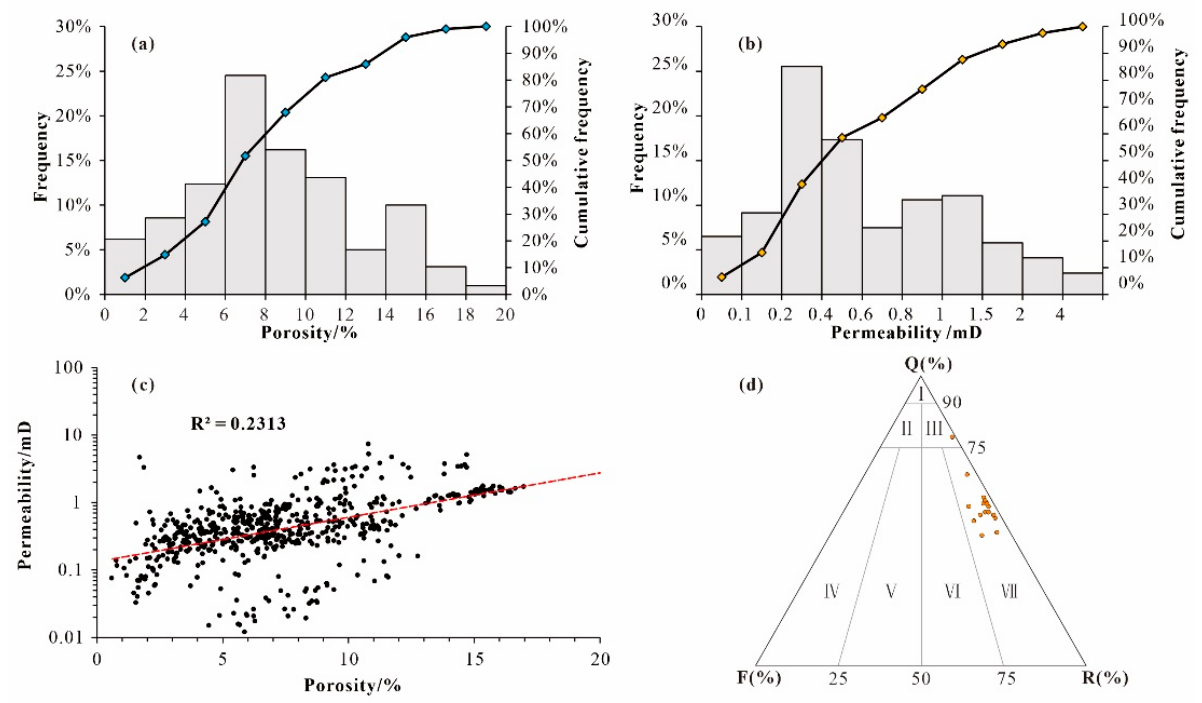
Figure 3. Histogram of ( a ) porosity and ( b ) permeability distribution, and ( c ) their correlation of Lower Shihezi Formation tight sandstones in the Duguijiahan block, Ordos Basin. ( d ) Quartz–feldspar–rock fragment ternary plot indicates that the lithology is litharenite (classification after [66]). Abbreviations: I: quartz arenite; II: subarkose, III: sublitharenite; IV: arkose; V: lithic arkose; VI: feldspathic litharenite; VII: litharenite.